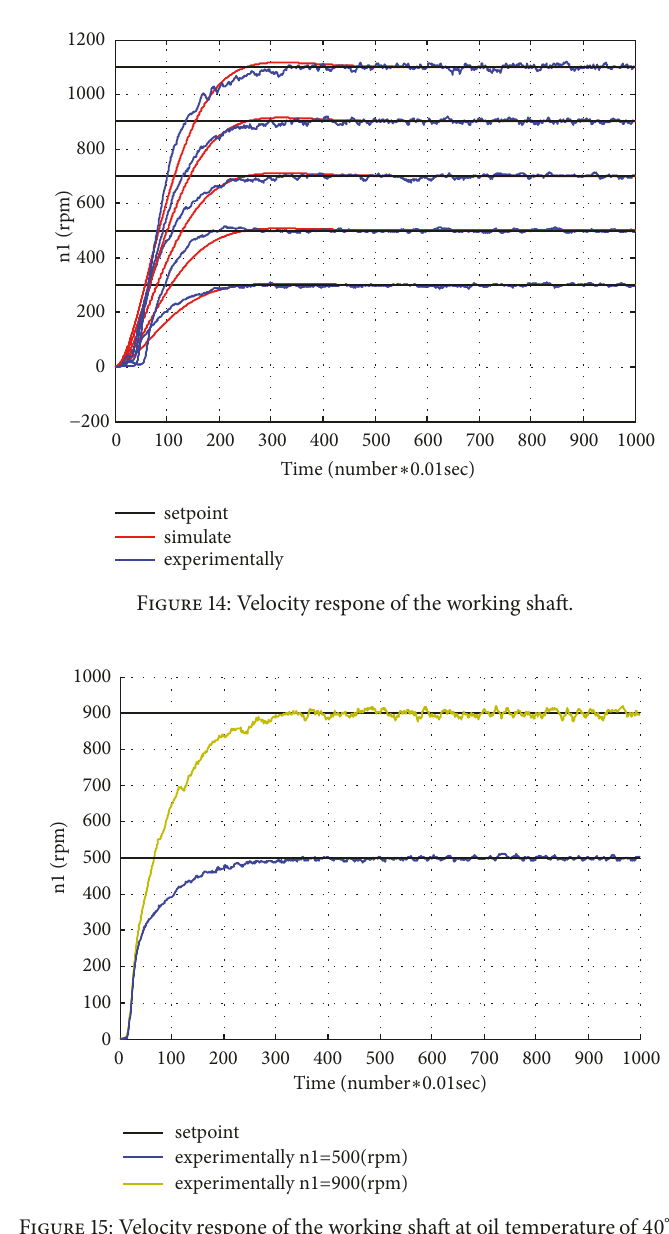
Figure 15: Velocity respone of the working shaft at oil temperature of 40 ∘